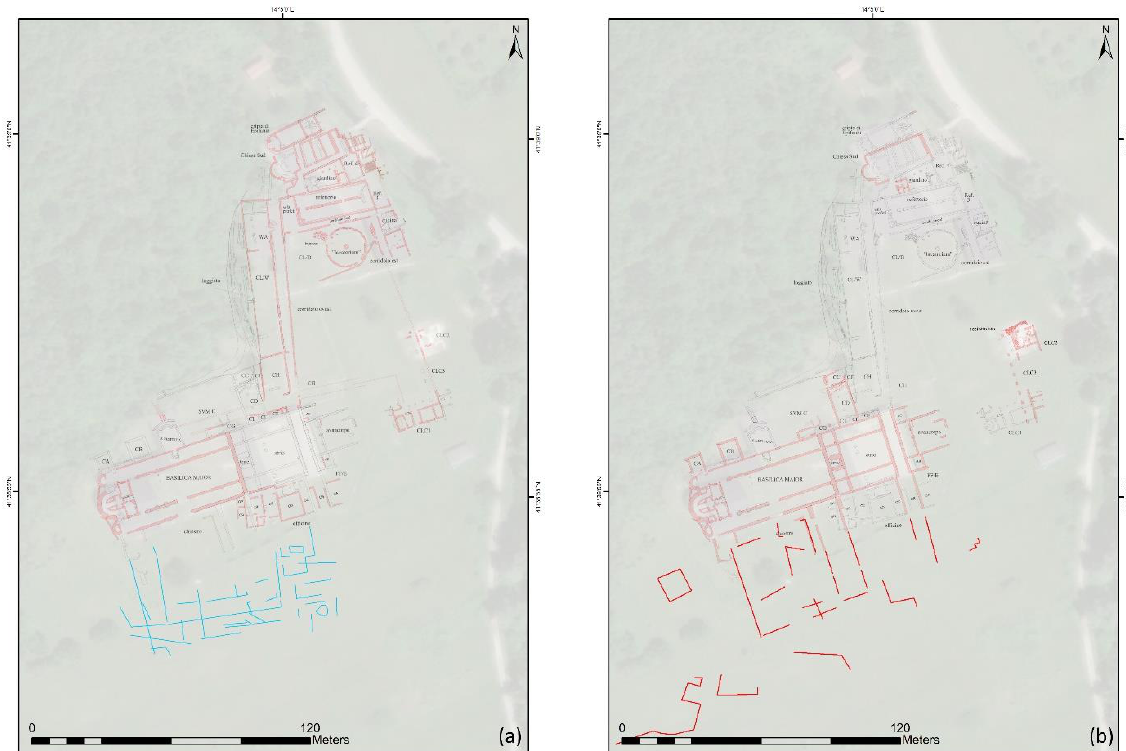
Figure 16. Identified features: ( a ) 2nd phase (9th century); ( b ) 5th phase (11th century).